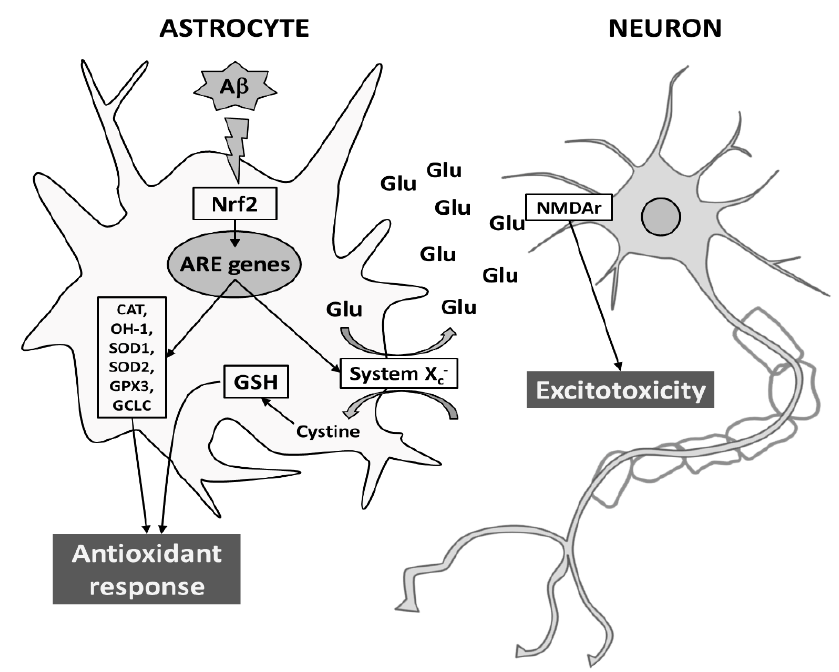
Figure 8. Proposed model for A β -dependent neurodegeneration during AD. In astrocytes, A β 25-35 elicits an antioxidant response by transcriptionally inducing Nrf2-driven ARE genes, such as CAT, HO-1, SOD1, SOD2, GPX3, GCLC, and System X c − . While the L-cystine import through System X c − is crucial to protection from oxidative stress (e.g., GSH production), the export of glutamate may cause neurodegeneration through the activation of NMDAr on neuronal cells. For more details see text.Abbreviations: A β , amyloid- β ; ARE, antioxidant responsive element; CAT, catalase; GCLC, glutamate-cysteine ligase; GPX3, glutathione peroxidase; GSH, reduced glutathione; HO-1, heme-oxygenase-1; NMDAr, N-methyl-D-aspartate receptor; Nrf2, nuclear factor erythroid 2-related factor 2; SOD, superoxide